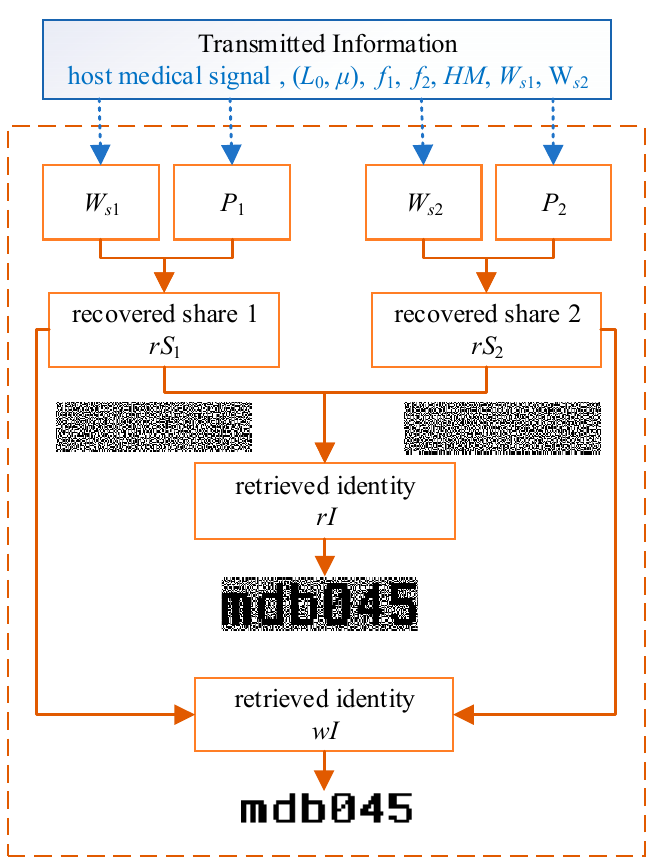
Figure 7. Block diagram of the extraction process of the proposed algorithm.